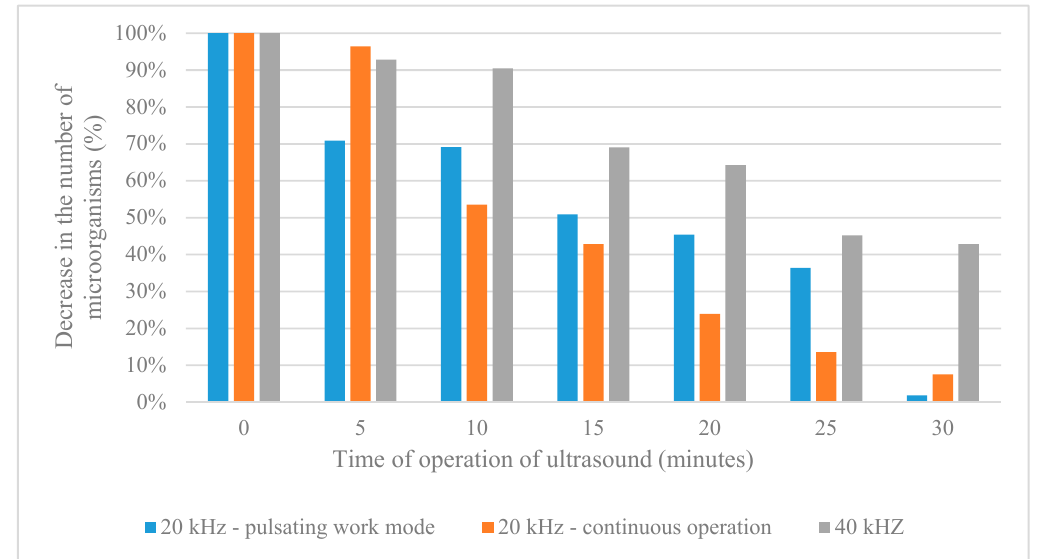
Figure 1. Percentage changes in the number of microorganisms present in mixed sludge subjected to ultrasound (own